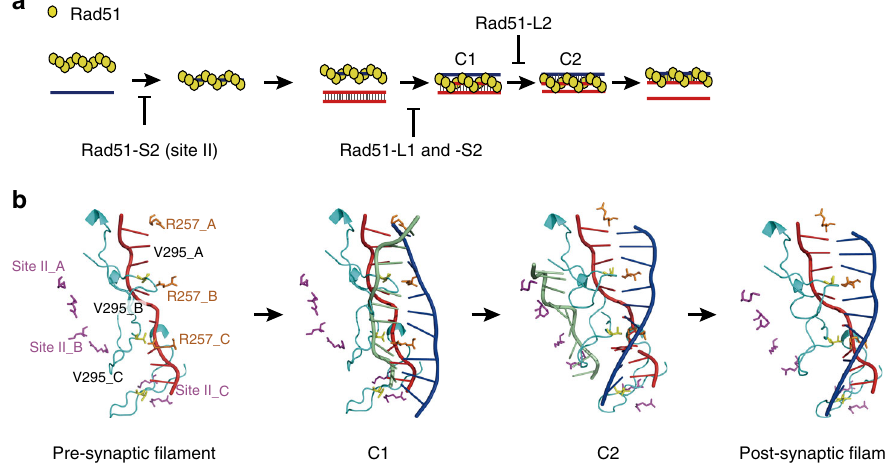
Fig. 7 A model of DNA strand exchange reaction driven by Rad51. a Roles of each DNA binding site of Rad51 in the DNA strand exchange reaction. Yellow circles, black lines, and red double-lines represent Rad51 monomers, ssDNA, and donor dsDNA molecules, respectively. b A model of the strand exchange reaction proceeding in order of the presynaptic fi lament (three Rad51 monomers binding to ssDNA are shown), C1, C2, and the post-synaptic fi lament. Only Arg-257 (orange) in L1, Val-295 (yellow) in L2 (light blue), and site II (Arg-324 and Lys-334, purple) are shown. A structural model of C1 was constructed by docking the SpRad51-ssDNA fi lament model shown in Fig. 1b and extended-dsDNA. The incoming dsDNA retains its duplex base-pairs and the invading ssDNA (red) aligns (but does not pair) with the complementary strand (blue) of the incoming dsDNA. Arg-257 in L1 and Val-295 in L2 of the presynaptic fi lament is arranged in close proximity with the complementary strand and the invading strand, respectively. Because of steric hindrance observed in the initial model (Supplementary Fig. 6a), the dsDNA is separated from site II (Arg-324 and Lys-334). A structural model of C2 was constructed by docking the SpRad51-dsDNA fi lament model shown in Fig. 1c and extended-ssDNA. A heteroduplex composed of the invading ssDNA (red) and the complementary strand (blue) of the incoming dsDNA is already engaged in base-pairing and the non-complementary ssDNA (green) is displaced from the incoming dsDNA. Arg-257 in L1 and Val-295 in L2 insert into the incoming dsDNA from opposite directions, stabilizing the heteroduplex DNA. Site II interacts with the displaced ssDNA. Source data are provided as a Source data fi